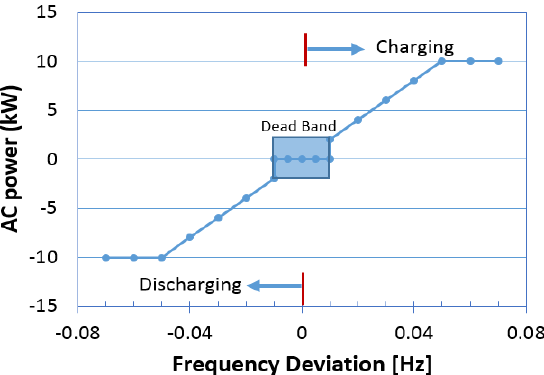
Figure 4. Droop-control characteristic designed for grid simulation on primary frequency control using V2G at the NRC‒CCHT.